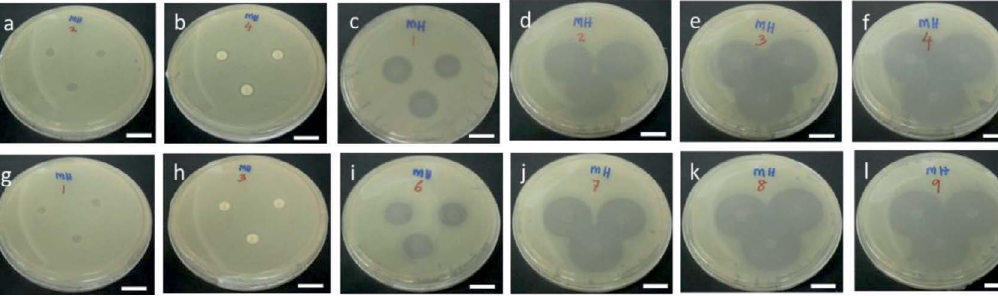
Fig. 5. Disk diffusion results of (a) GG (negative control), (b) penicillin (positive control), (c) GG-NOR001, (d) GG- NOR01, (e) GG-NOR05, and (f) GG-NOR1 films against Escherichia coli , respectively, and (g) GG (negative control), (h) penicillin (positive control), (i) GG-NOR001, (j) GG-NOR01, (k) GG-NOR05, and (l) GG-NOR1 films against Staphylococcus aureus . Scale bar represents 2